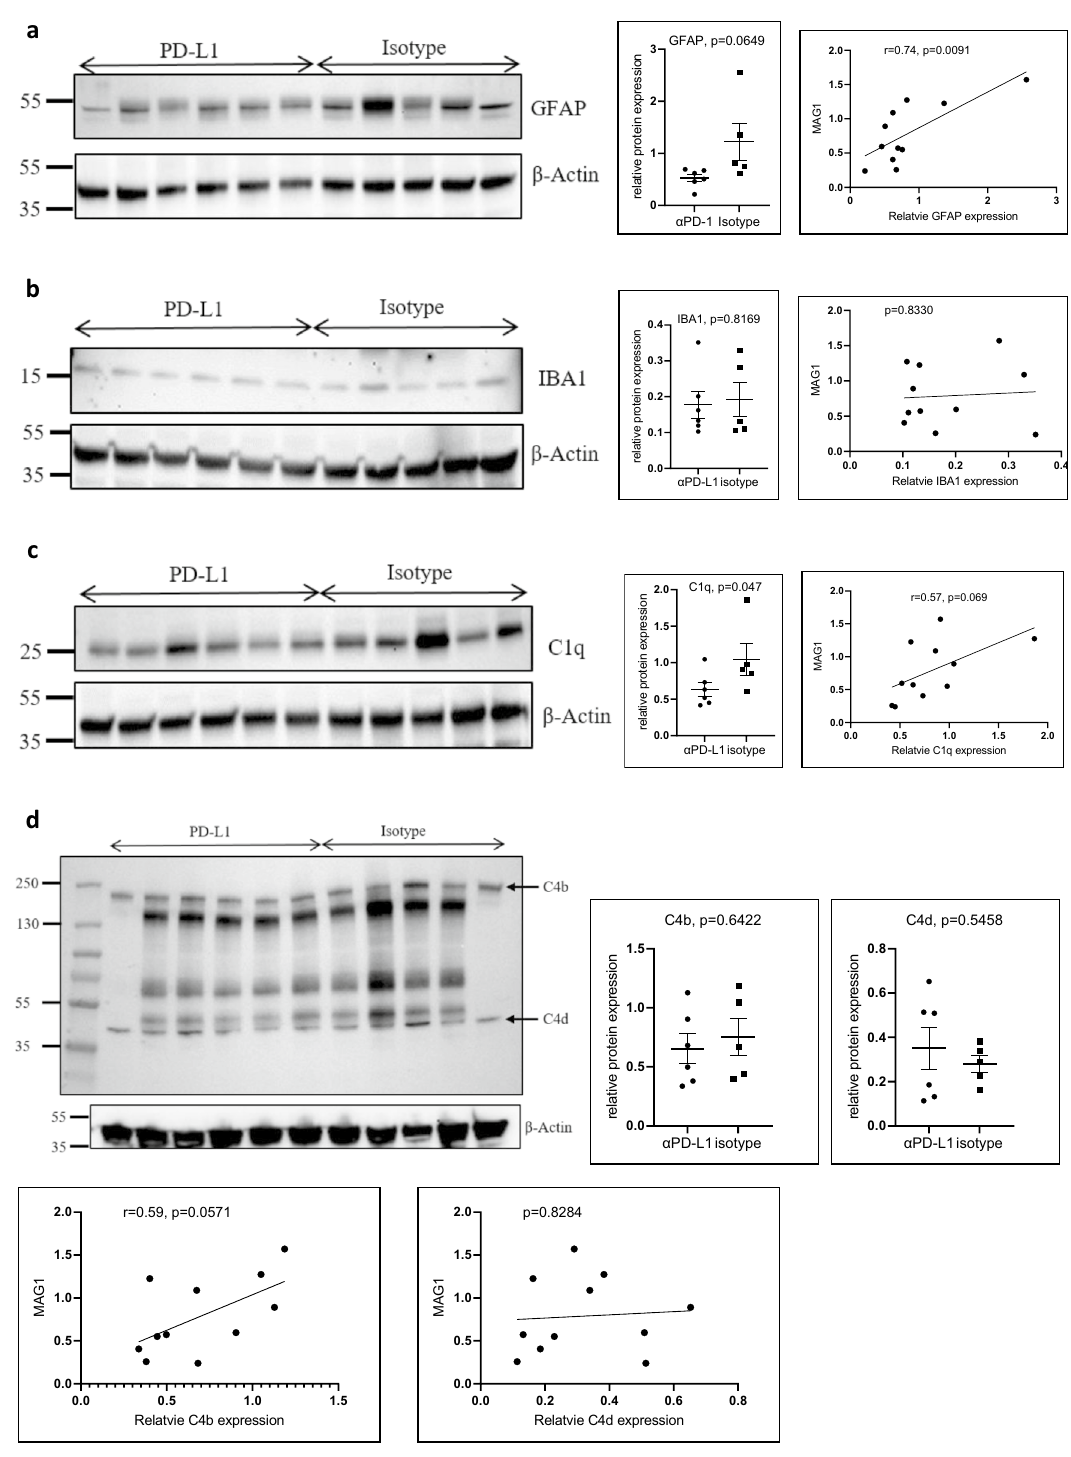
Figure 5. PD-L1 blockade on the suppression of glial and complement activation. Protein expression levels of GFAP ( a ), IBA1 ( b ), C1q ( c ), and C4 ( d ) were compared in brain homogenates of mice that received αPD-L1 (n = 6) and isotype control (n = 5), alongside β-actin loading controls by western blot. The analysis was run on a 4–20% polyacrylamide gel under either reducing ( a , b , c ) or non-reducing conditions ( d ). Histograms indicate densitometric analysis of blots, expressed as means + SEM, with individual data points. The relative protein expression was assessed with MAG1 antibody levels measured post-treatment by Pearson’s correlation analysis (n = 11). Analysis was performed in three independent experiments. The dots show individual values from one representative experiment. Significance was determined with a student’s